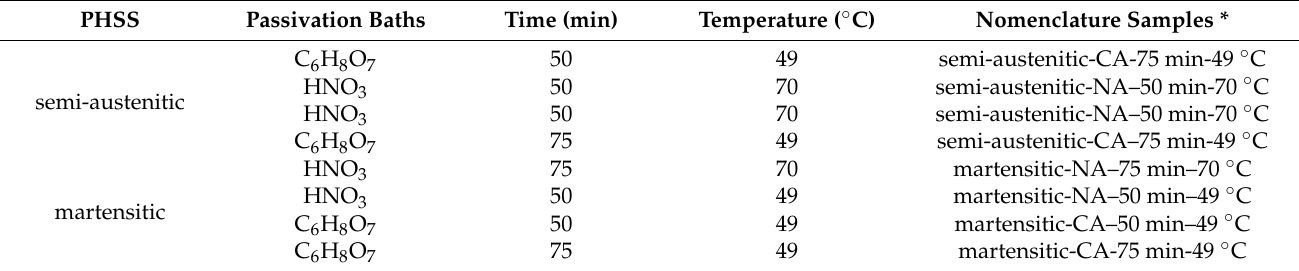
Figure 1. Diagram of passivation treatment of PHSS. Table 2. Nomenclature and passivation treatment parameters.